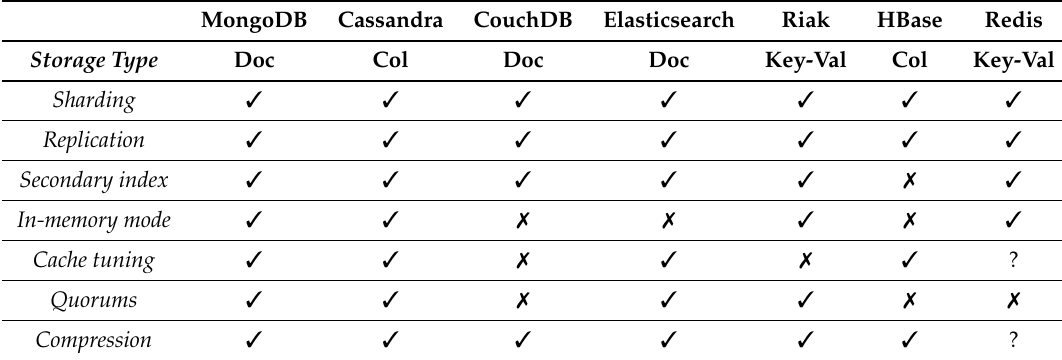
Table 1. Performance and scalability tactics in contemporary NoSQL storage